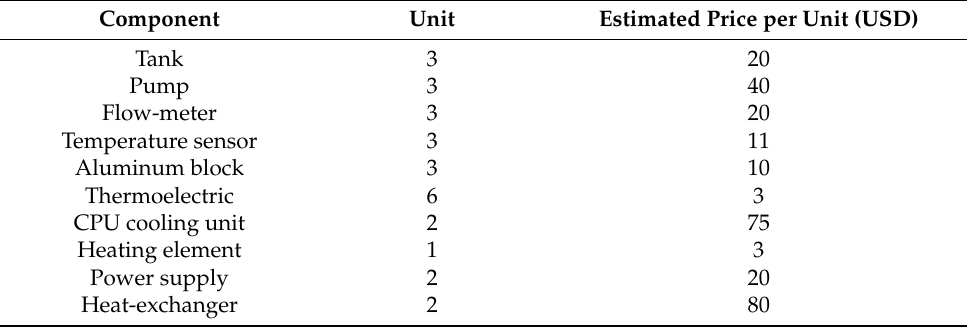
Table 2. Cost analysis of the developed system.